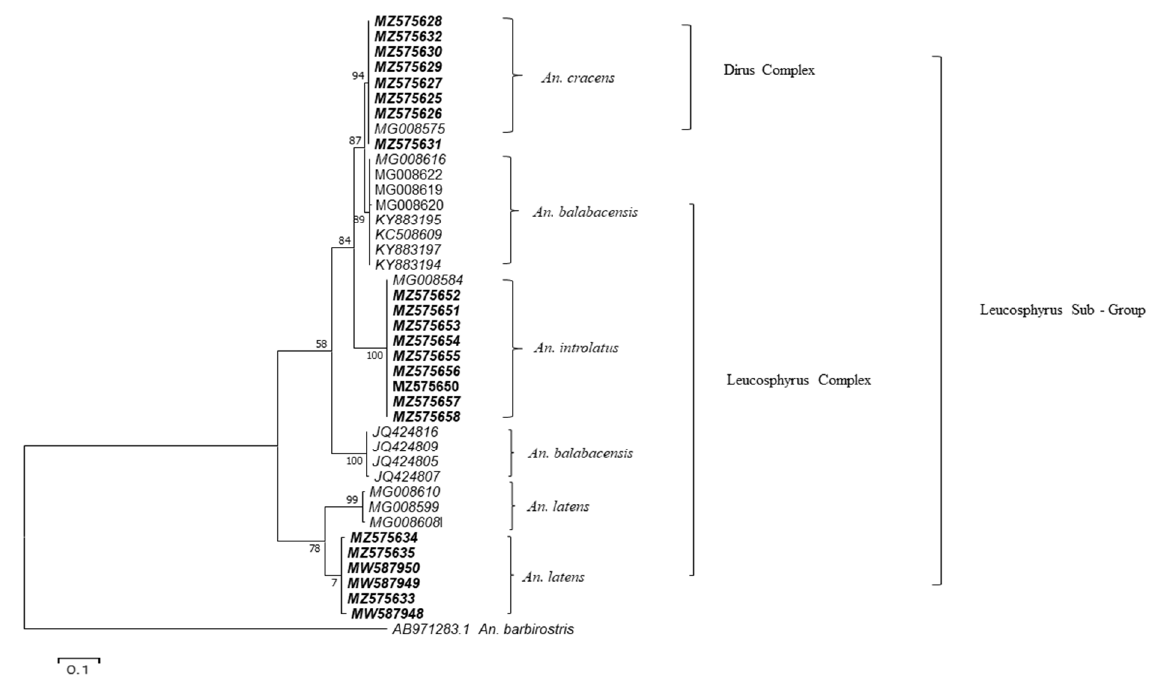
Figure 2. Phylogenetic tree of Anopheles Leucosphyrus group specimens sampled from six localities in Malaysia conScheme 2. sequence. The sequences in bold were deposited by this group, while unbold sequences are from Gene Bank.